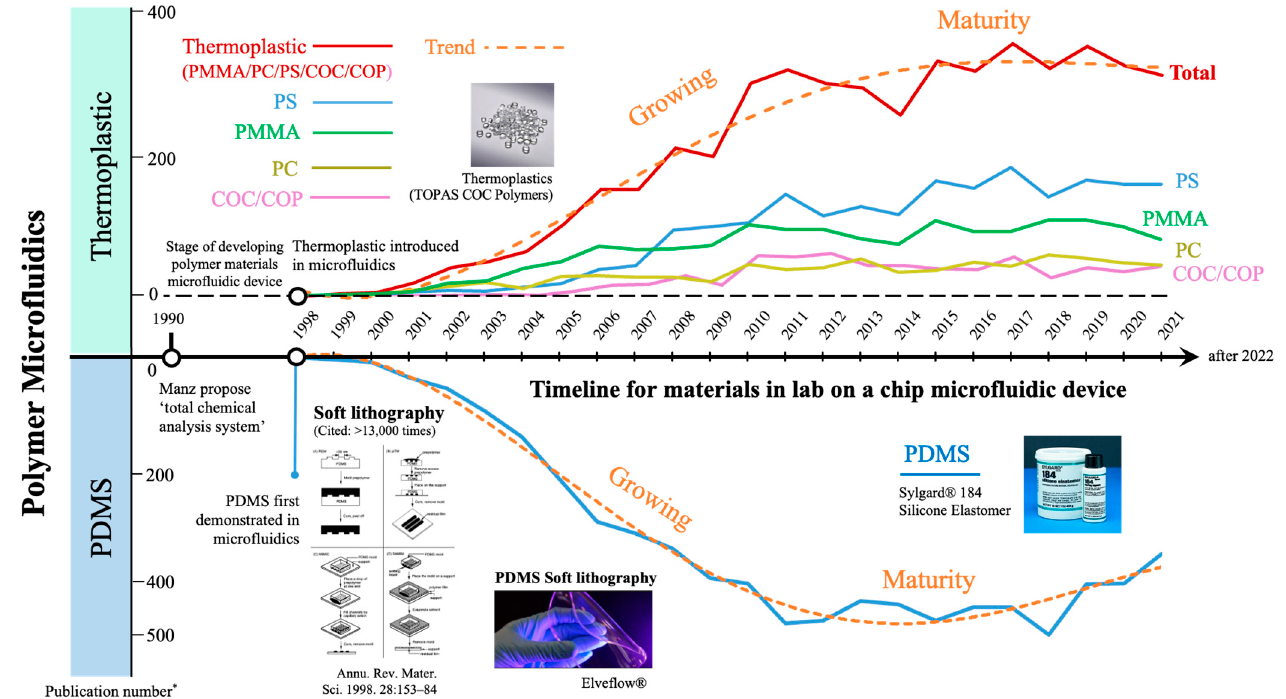
Figure 1. Development trends of PDMS and thermoplastic in microfluidics. * The publication numbers are analyzed by the Web of Science website and the data were collected until December 2021.